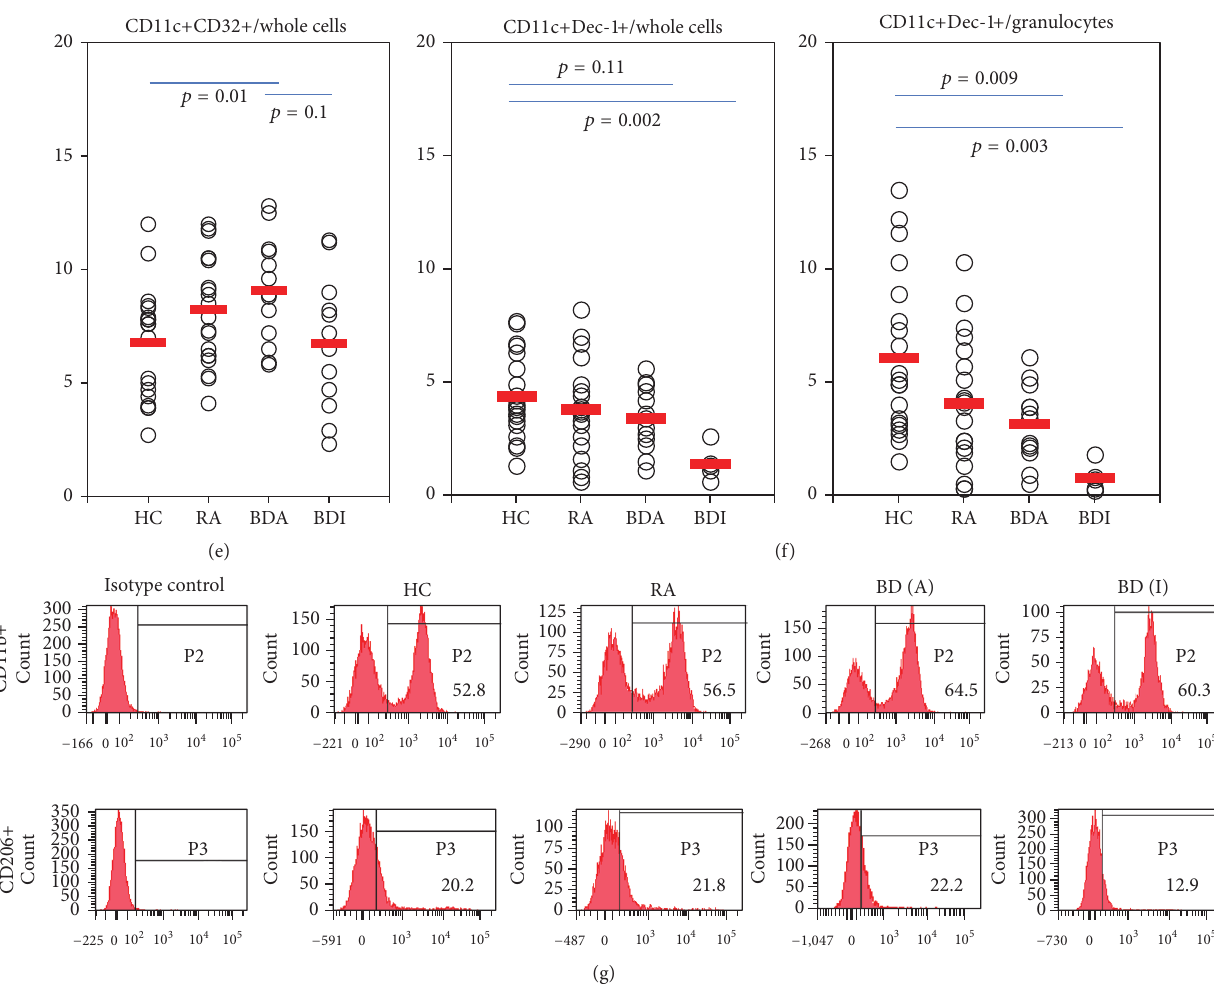
Figure 2: The frequencies of double positive cells in patients with active Behc¸et’s disease (BDA), inactive BD (BDI), rheumatoid arthritis (RA), and healthy control (HC). CD11b+CD206+, CD11b+CD32+, CD11b+Dectin-1+, CD11c+CD206+, CD11c+CD32+, and CD11c+Dectin- 1+ cells were analyzed in whole leukocytes, granulocytes, and monocyte (a–f). (g) Representative histograms of CD11b+ and CD206+ cells in HC, RA, BDA, and